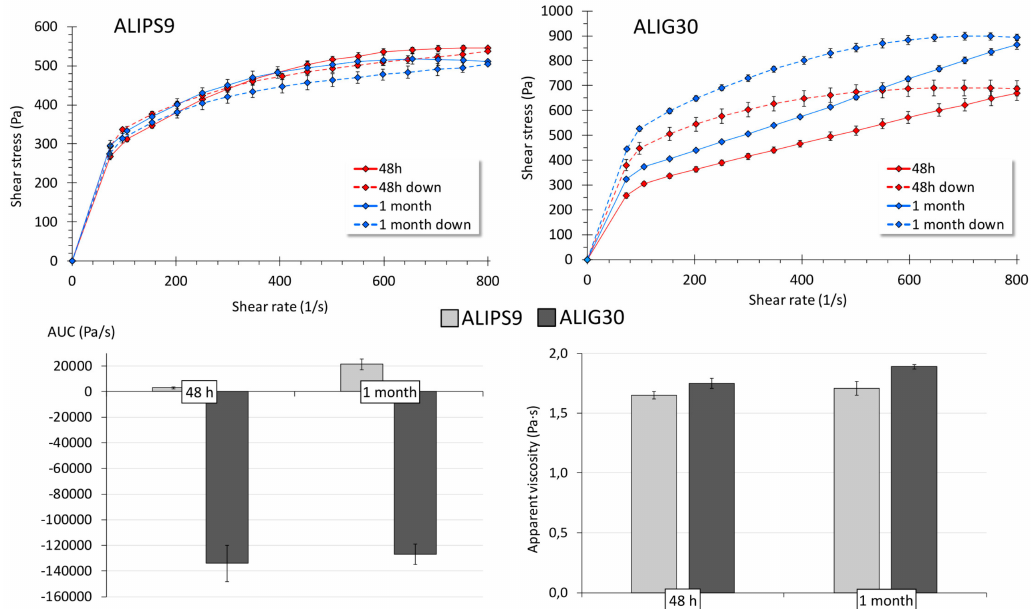
Figure A1. Rheological characterization of ALIPS9 and ALIG30@20 hydrogels after 48 h and 1 month. Up: flow curves (from 70 to 800 s − 1 , mean values ± s.d., n = 6). Down: hysteresis areas (mean values ± s.d., n = 6) and apparent viscosities (250 s − 1 , mean values ± s.d., n = 6). Positive AUC values indicates thixotropic behavior, while negative ones correspond to anti-thixotropic profile. Table A1. Amount of mobile elements released from the corresponding hydrogels into fibroblast cultures (MTT well-plate). Results were calculated from Franz experiments at 1 month and expressed in nanograms. NM stands for “Not